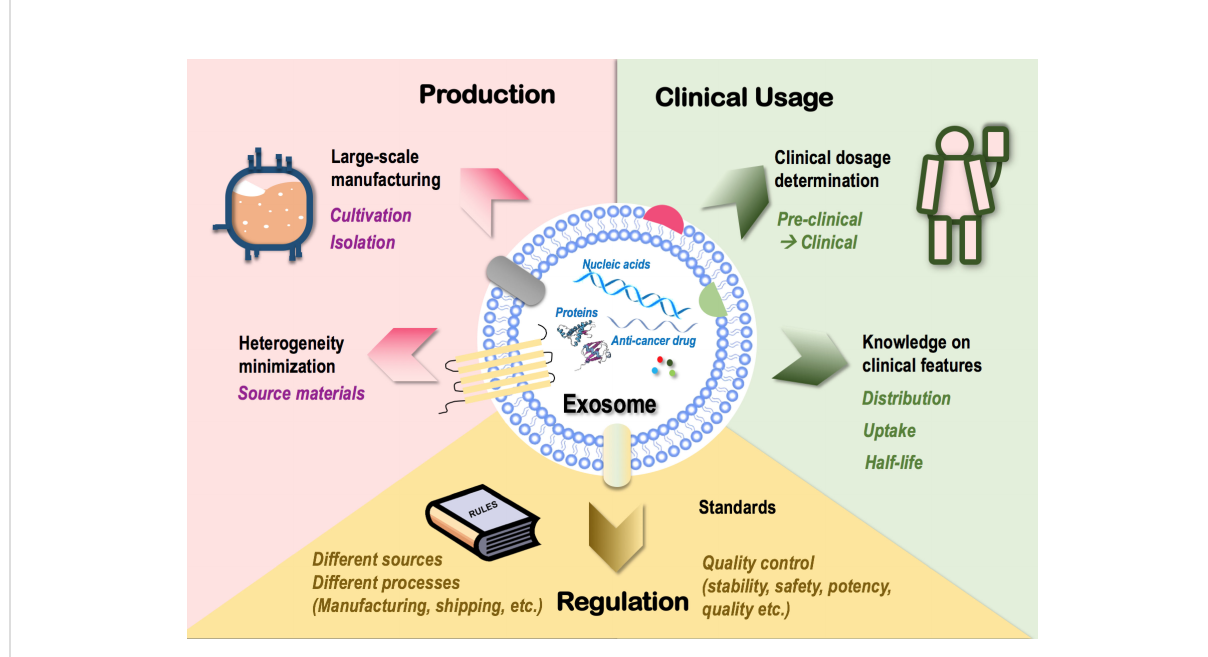
FIGURE 3 Challenges limiting the clinical translation of exosomes as onco-therapeutics. Challenges limiting the clinical translation of exosomes fall into three categories, i.e., exosome production, clinical usage, and regulation. In “ production, ” techniques that enable large-scale exosome manufacturing such as source cell cultivation and exosome isolation, and techniques minimizing exosome heterogeneity such as control over the heterogeneity of source materials are limiting factors. In “ clinical usage, ” knowledge on exosome dosage for clinical use and clinical features of exosomes such as distribution, cell uptake, and half-life are limiting factors. In “ regulation, ” lack of a set of industrial standards feasible for the manufacturing and shipping processes of exosomes derived from different sources and lack of quality control guidelines over exosome stability, safety, potency, and quality are limiting